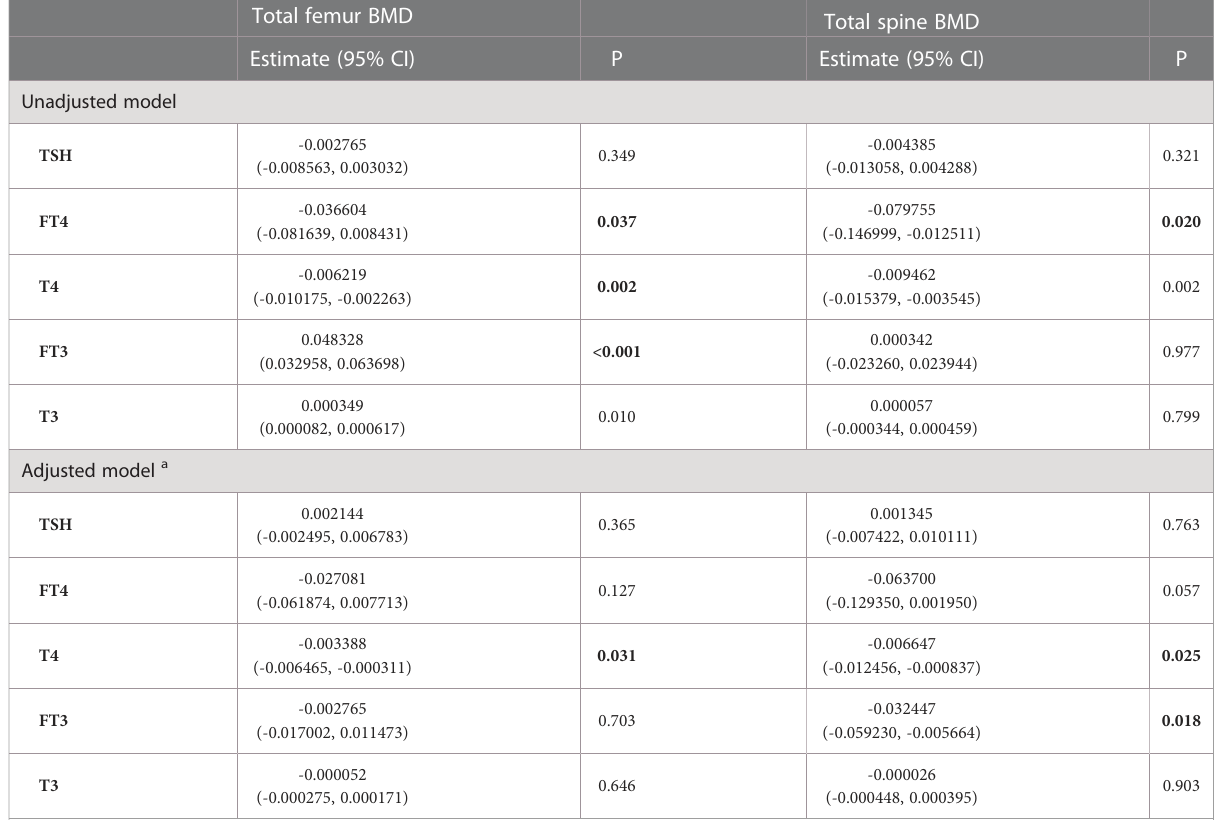
TABLE 7 Association of the thyroid hormone pro fi le with BMD in participants with